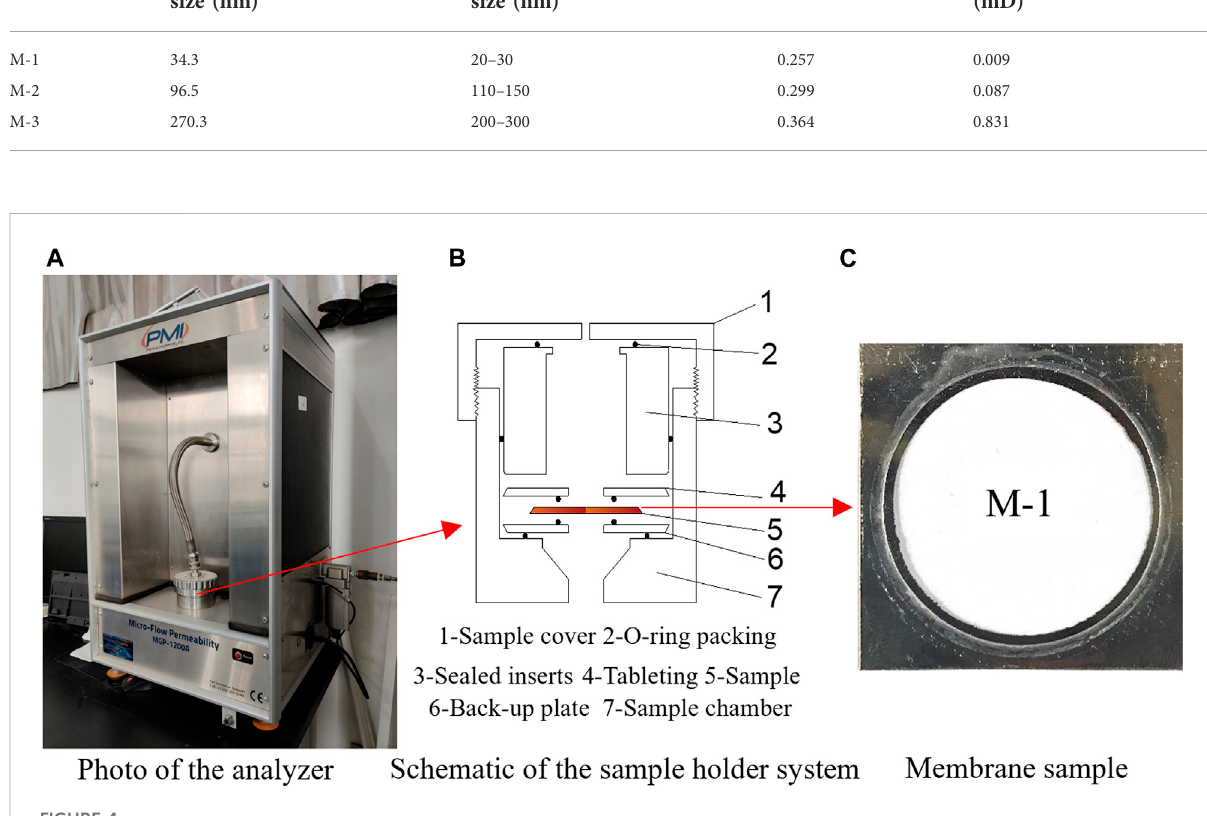
FIGURE 4 Gas micro fl ow-permeability analyzer. (A) Photo of the analyzer, (B) Schematic of the sample holder system, (C) Membrane